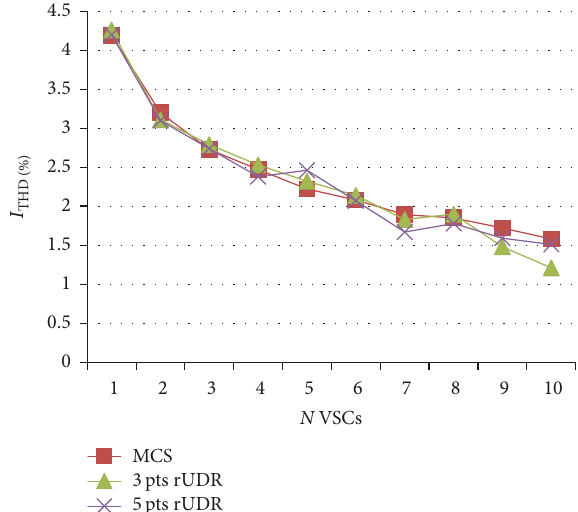
Figure 7: Predicted IgaTHD using MCS, rUDR 3 pts, and rUDR 5 pts under Power